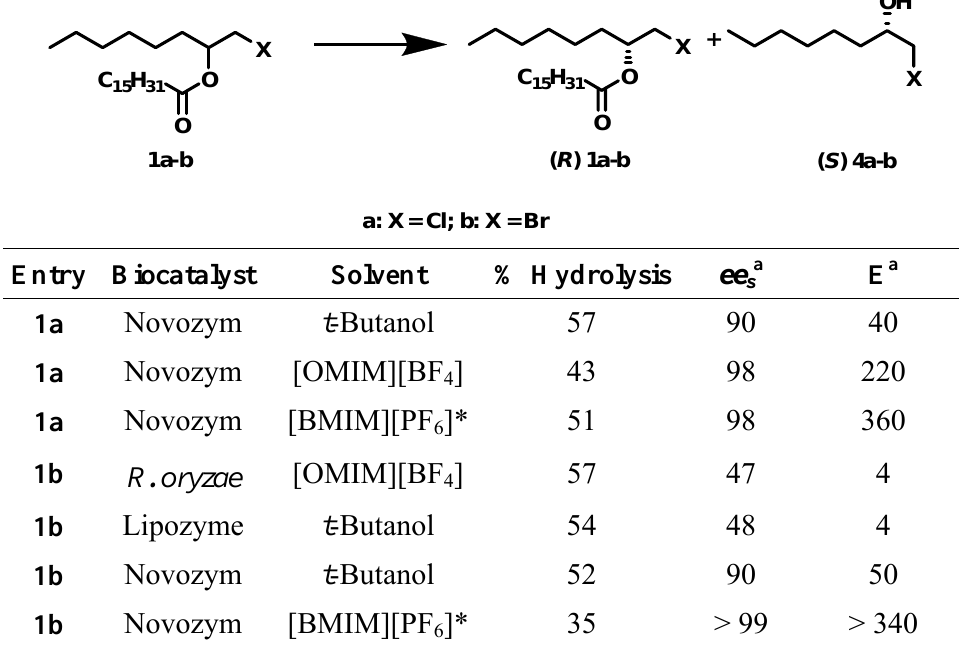
Table 2. Percentage hydrolysis, ee various biocatalysts and